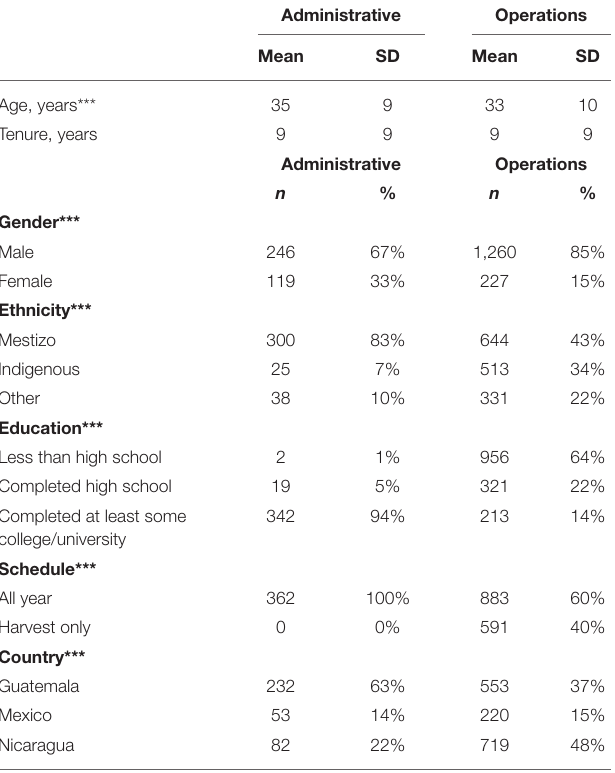
TABLE 2 | Description of study sample by type of worker ( N = 1,861). TABLE 3 | Description of study variables by type of worker.